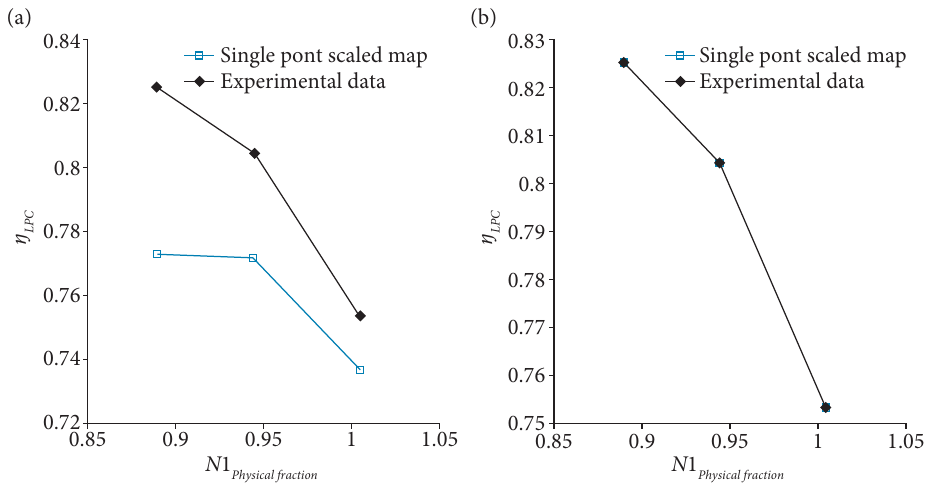
Figure 4. Comparison of efficiency values from characteristics map and experimental data before multipoint scaling (a) and after multipoint scaling (b).